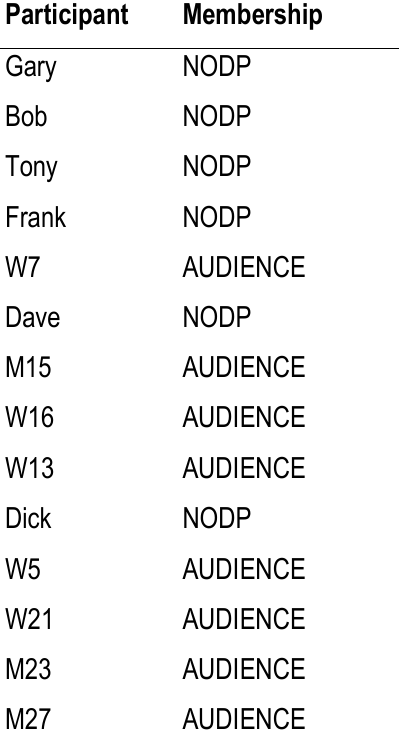
Meeting Participants Who Take Long